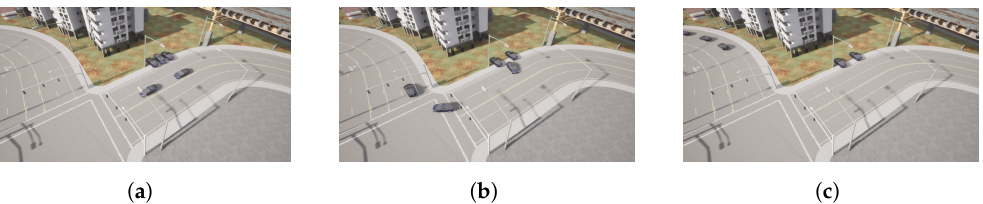
Figure 17. Follower 2 pick-up process. ( a ) Follower 2 waiting. ( b ) Follower 2 de-parking. ( c ) Follower 2